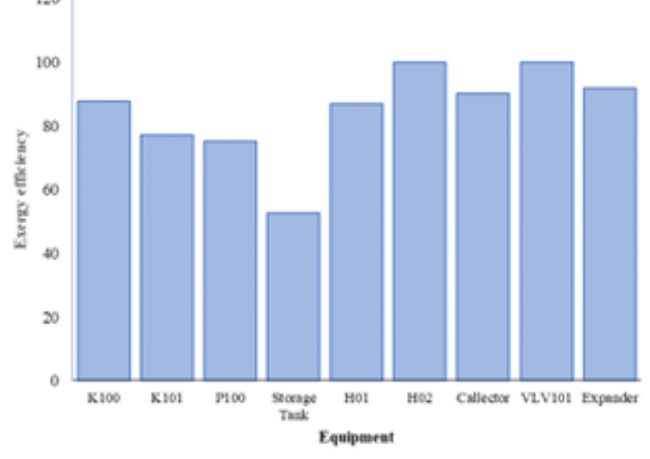
Figure 4. Exergy efficiency of all